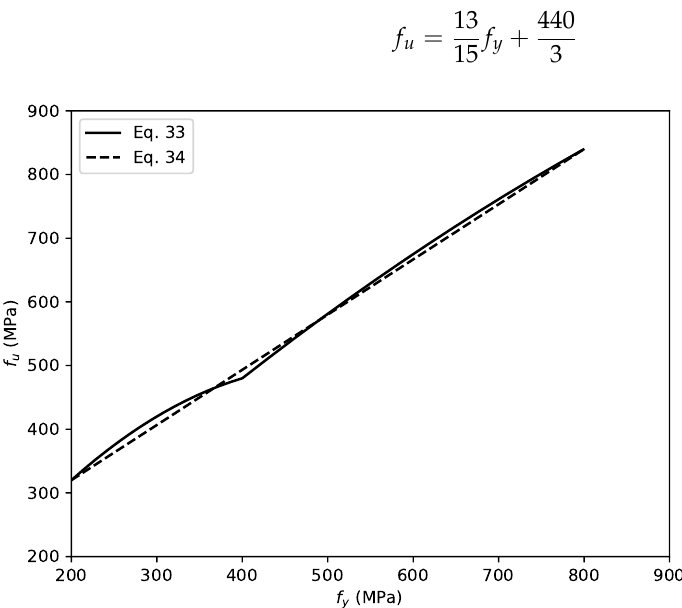
Figure 9. Relationships of ultimate stress f u and yield strength f y